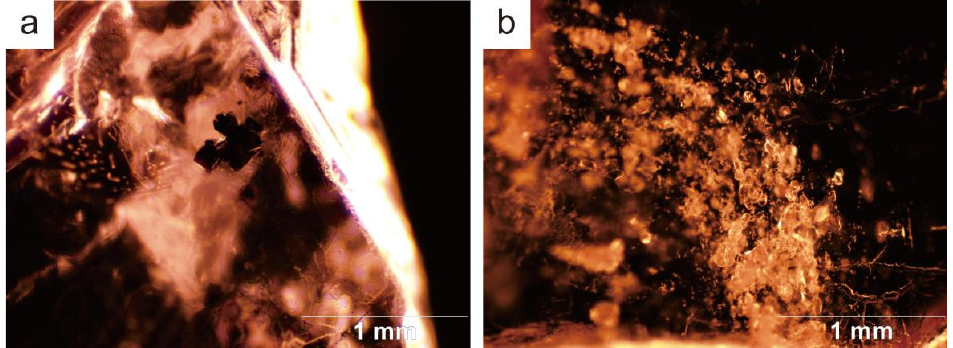
Figure 6. ( a ) Black inclusions (rutile) in a Tajikistani spinel (T − 5). ( b ) Colorless crystals (apatite and zircon) in two size clusterings in a Tajikistani spinel (T − 3).